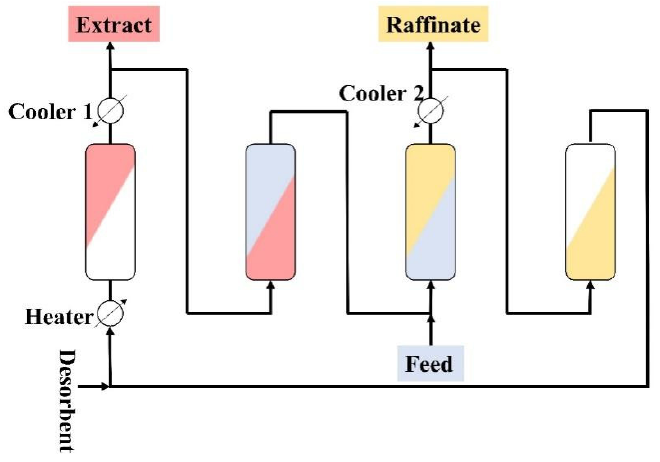
Figure 11. Schematic diagram of temperature gradient.